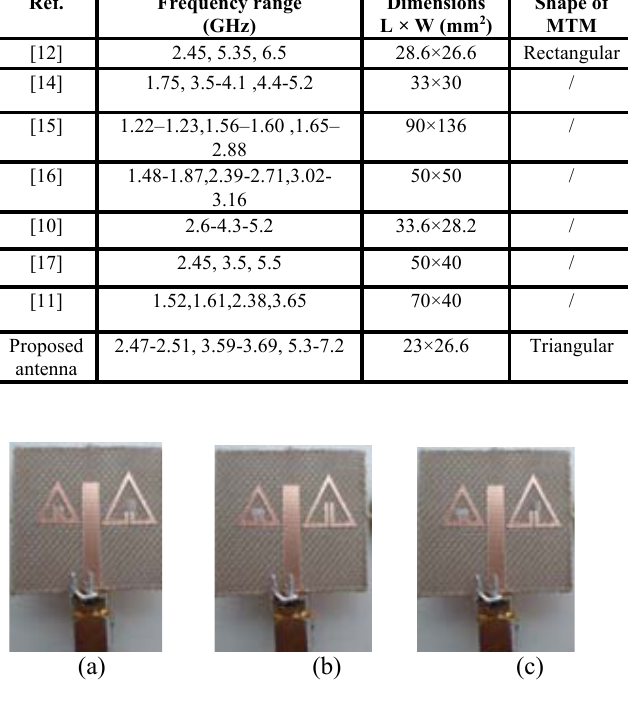
Fig.13 Geometry of antenna configuration;(a) cell-1 OFF,(b) cell-2 OFF and (c) cell-1/cell-2 OFF